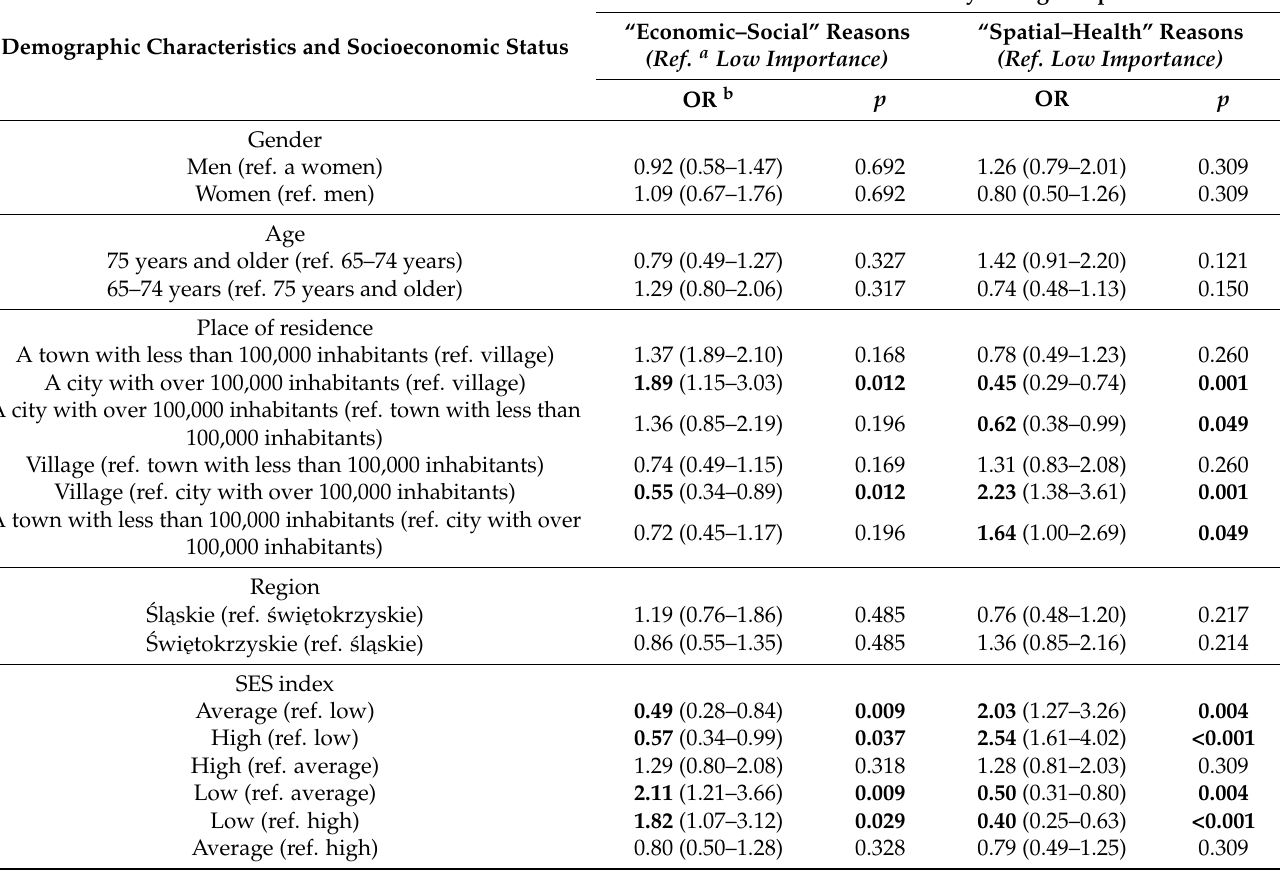
Table 3. Odds ratios for food insecurity reasons of high importance according to selected demographic characteristics and socioeconomic status of the study